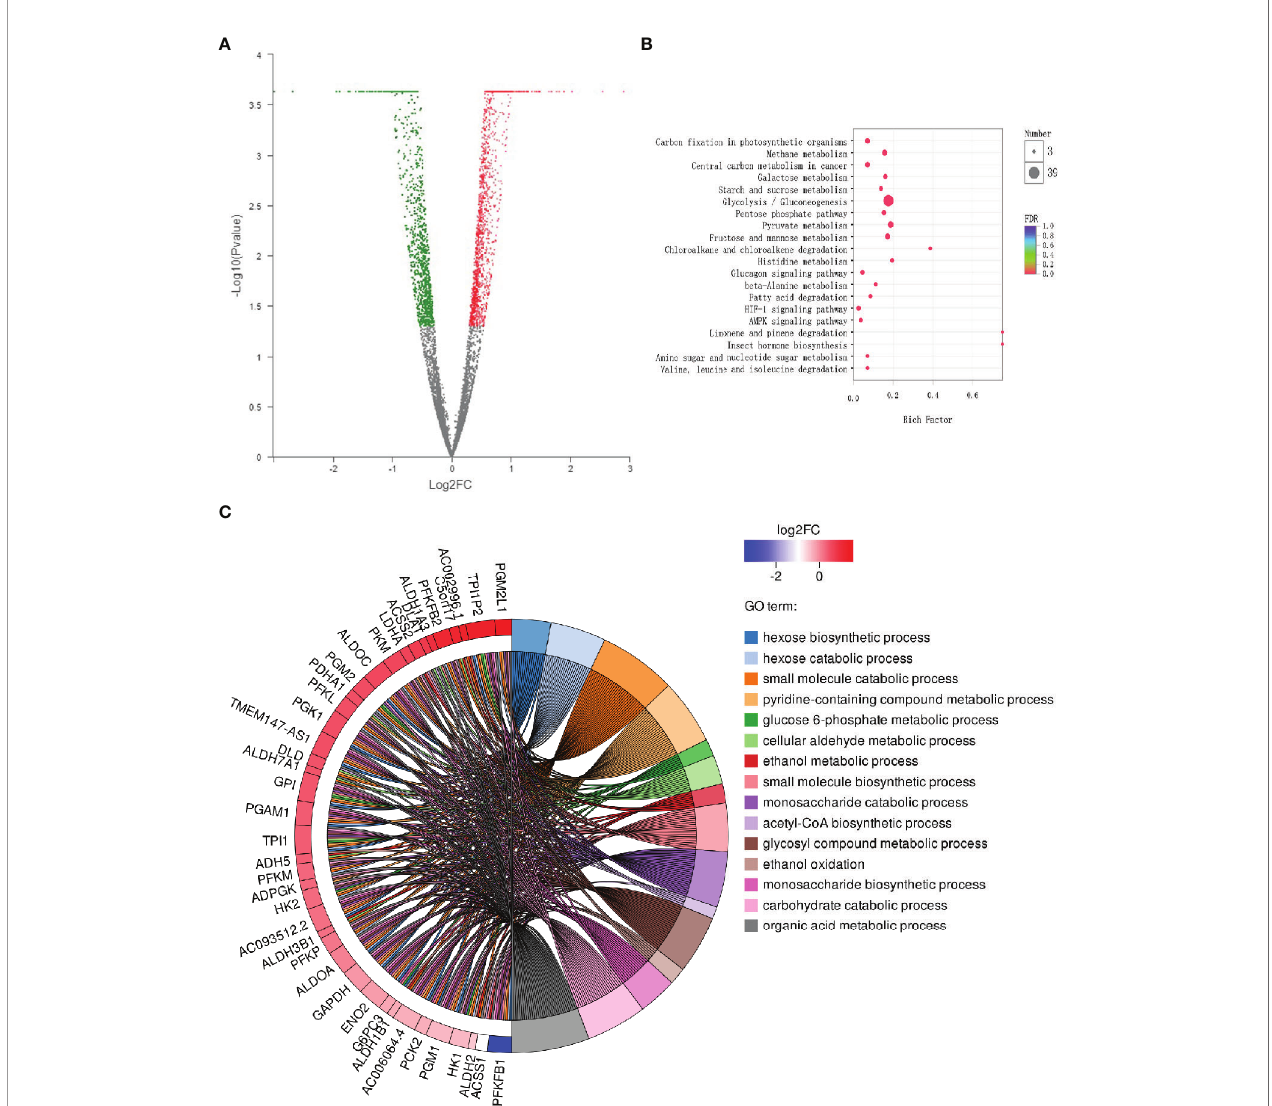
FIGURE 1 | Differential expression of cancer-related genes following administration of esculetin (each group, n=3). (A) A volcanic map. Each dot represents a speci fi c gene; red dots are signi fi cantly up-regulated genes, blue dots signi fi cantly down-regulated genes, and black dots represent non-signi fi cantly differentially expressed genes. The point on the left is the gene with a down-regulated expression difference, and the point on the right is the gene with an up-regulated expression difference. (B) KEGG enrichment analysis of cancer-related genes. The colors of the dots correspond to different Q value ranges. (C) GO enriched string diagrams. The larger log2FC, the larger the expression difference of up-regulated genes; the smaller log2FC is, the larger the expression difference of down-regulated genes; and the closer log2FC is to 0, the multiple of a genes differential expression was smaller. GO term information on the signi fi cant enrichment of differentially expressed genes is on the ( Figure 1C ). The enriched processes of DEGs focused on the processes related to glycolysis that are specially utilized by cancer, which may be